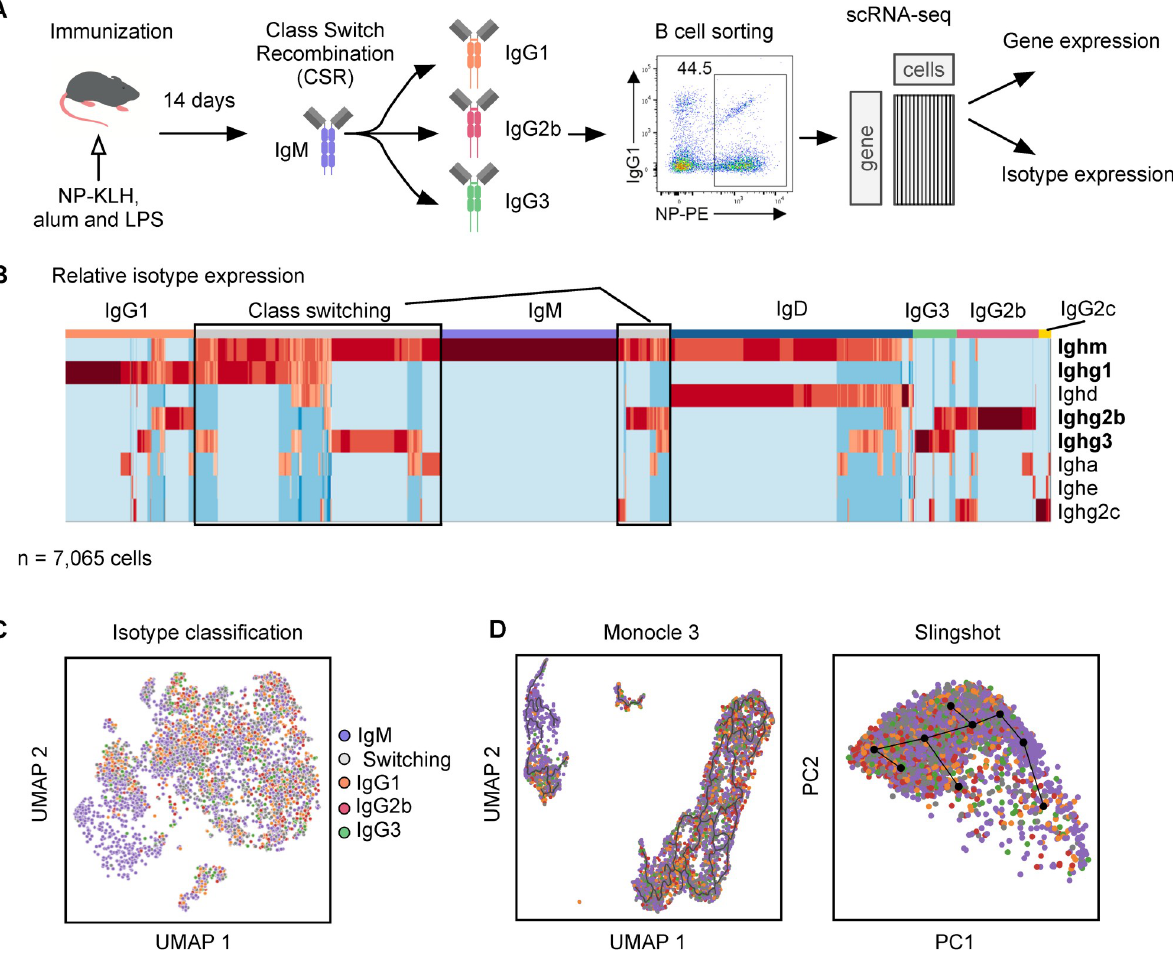
Fig 2. Class switch recombination process. (A) Overview of experimental system. (B) Relative isotype expression for all cells. N = 7,065. All isotype expressions sum to one for a given cell. (C) UMAP of RNA-seq data, colored by isotype. (D) Output from Moncole3 and Slingshot.